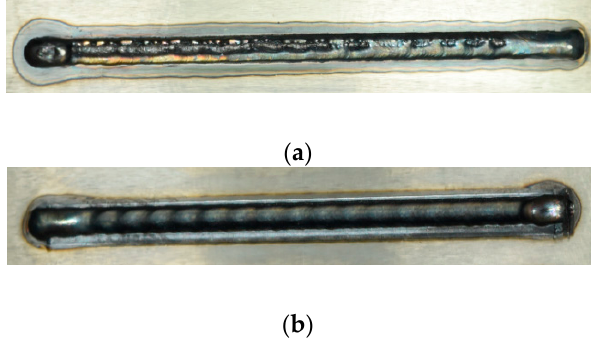
Figure 7. Comparison between welding beads realized at 1700 W cw power only ( a ) and at 1700 W cw combined with 81 W pw power at 7500 Hz ( b ). For cw use only, the power is not sufficient to completely melt the wire.